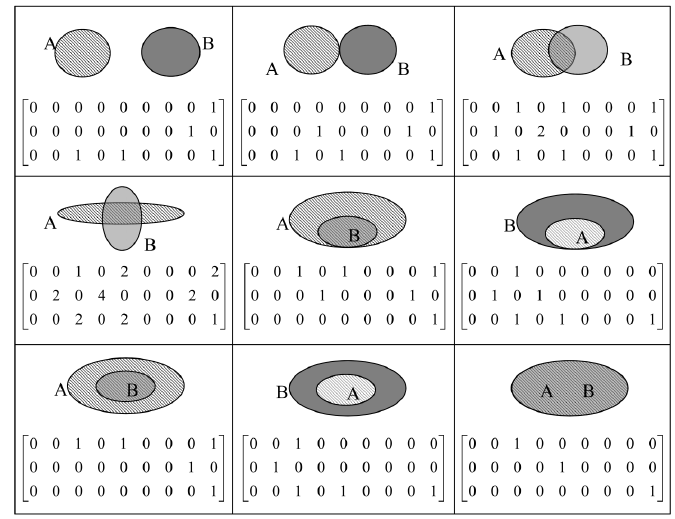
Figure 8. The formalism of the 27IM and the corresponding geometric interpretations between two regions.